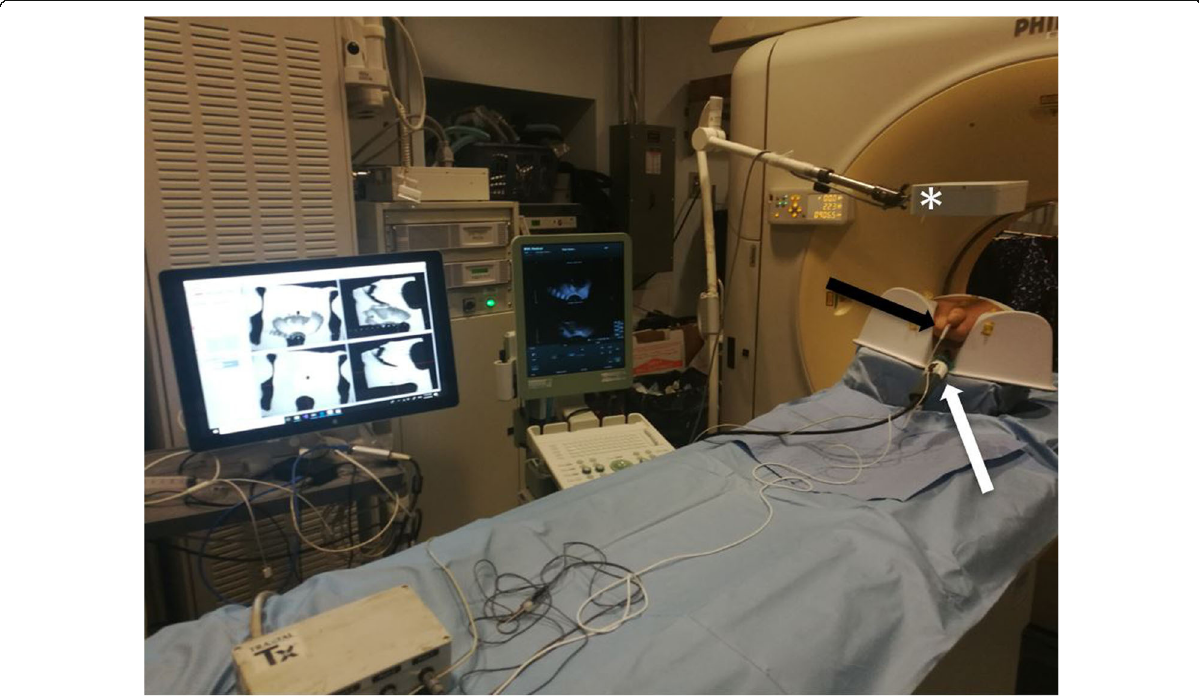
Fig. 4 Tracked Foley catheter (TFC) test-bed experiment. The screen on the left shows the custom fusion biopsy software platform (Onconav, National Institutes of Health, USA). The TFC prototype ( black arrow ) enters the anthropomorphic phantom urethra. Ultrasound transducer in phantom rectum ( white arrow ). Electromagnetic field generator ( asterisk